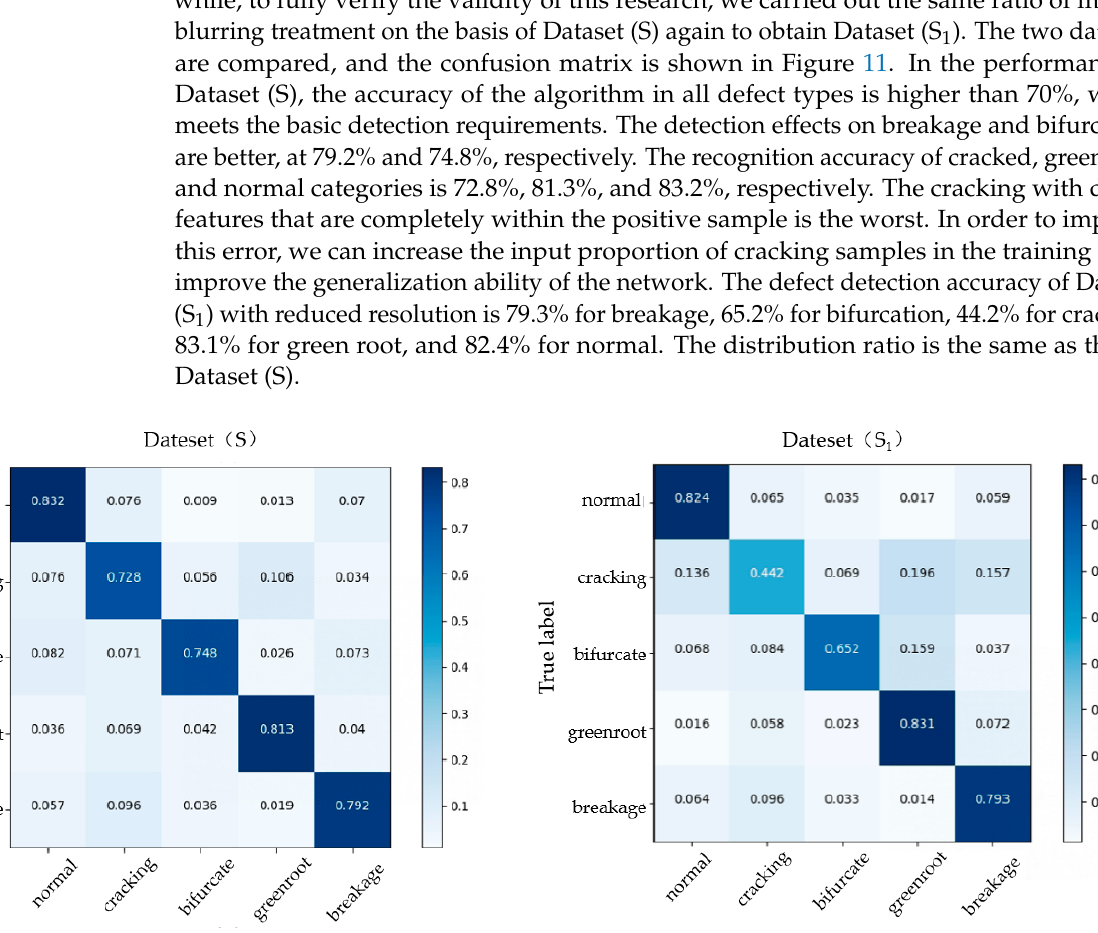
Figure 10. Model features visualization of part layers. ( a ) Features of the teacher network; ( b ) Fea- tures of student network with supervision; ( c ) Features of student network without supervision.